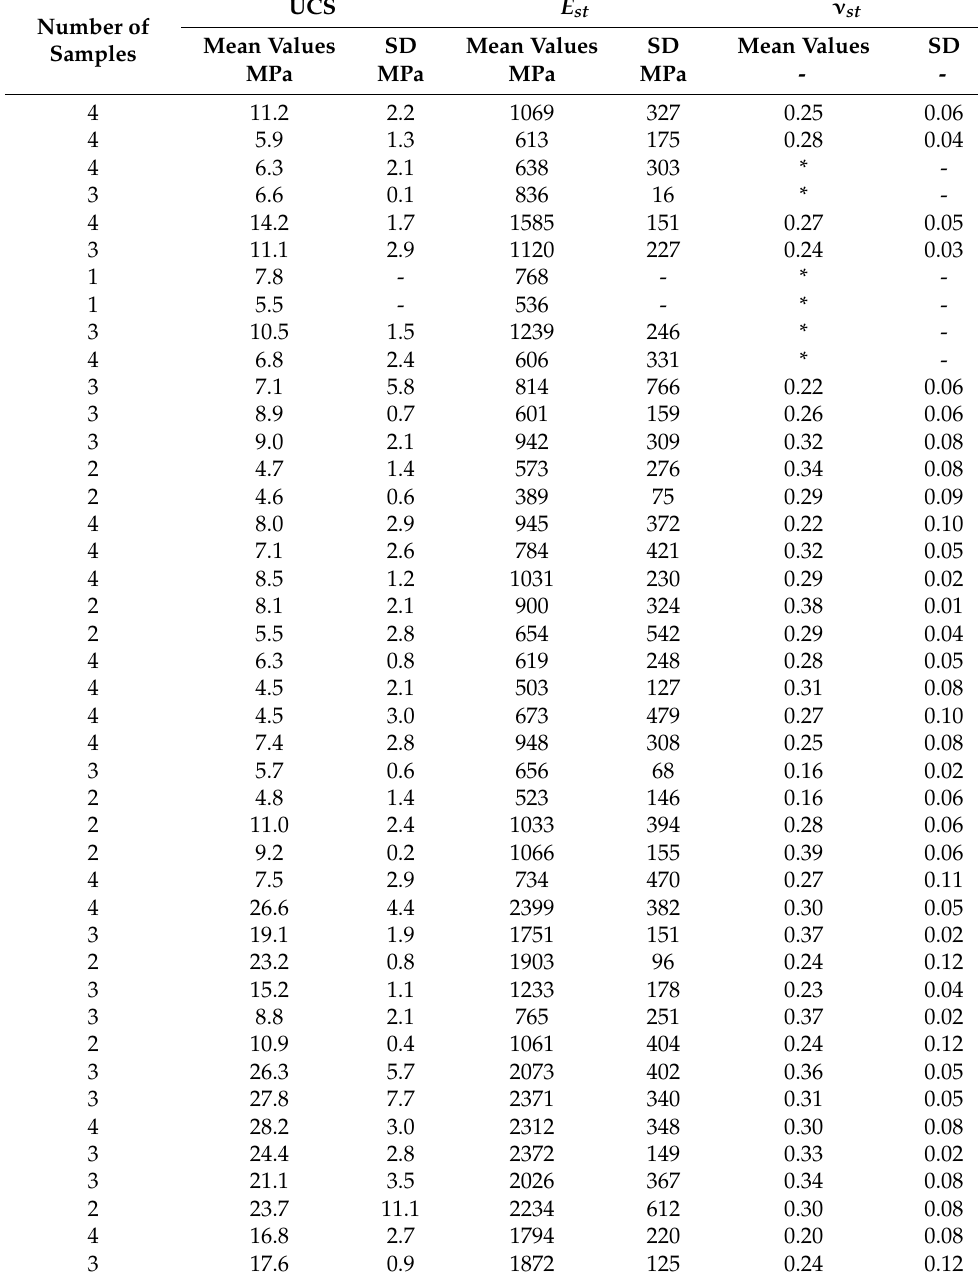
Table 3. Mean physical parameter values of coal specimens: static